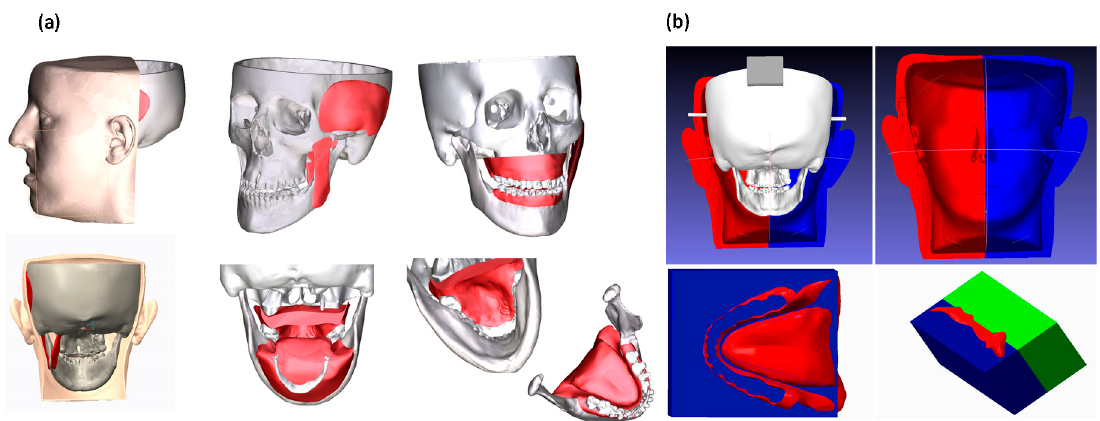
Figure 2. ( a ) 3D virtual model of skull, muscles, soft tissues and facial skin designed for producing the maxillofacial phantom starting from real patient imaging. ( b ) Molds designed for producing the soft components by silicone casting. J. Clin. Med. 2020 , 9 , x FOR PEER REVIEW Figure 3. The produced maxillofacial phantom: ( a ) the simulated skin; ( b ) the phantom in use with surgical tools; ( c ) detail of the reproduced teeth and gums.